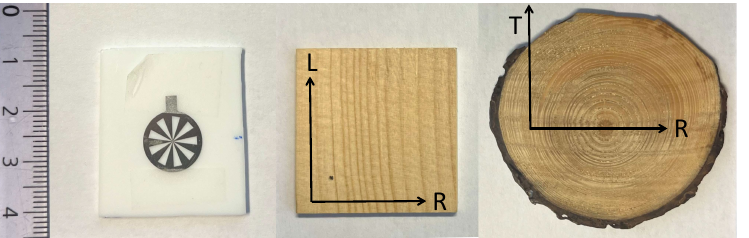
Figure 3. Resolution sample ( left ), wood sample #1; LR spruce ( middle ), wood sample #2; RT spruce from branch ( right ), scale in cm; wood directions R, T, and L are shown in the figure.